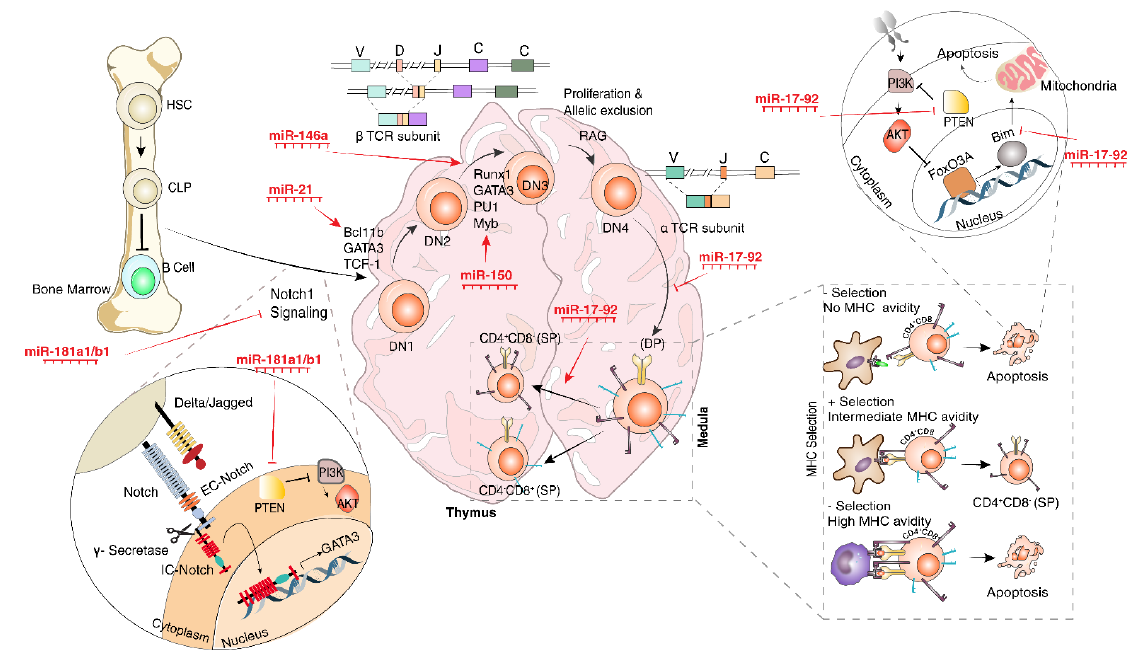
Figure 2. MiRNAs involved in common lymphocyte progenitor differentiation into T-cells. During